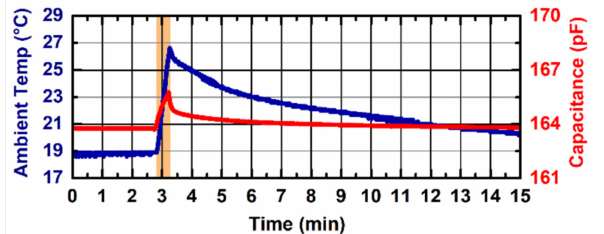
Figure 6. Results of the capacitance stability measurement (red line—right y -axis) over 8 ◦ C ambient temperature (blue line—left y -axis) variation for the probe V2 with a hydrogel layer and no contact applied to the sensor surface. Ambient temperature is increased from 18.6 to 26.6 ◦ C in 30 s (orange- shaded area) and then let return to